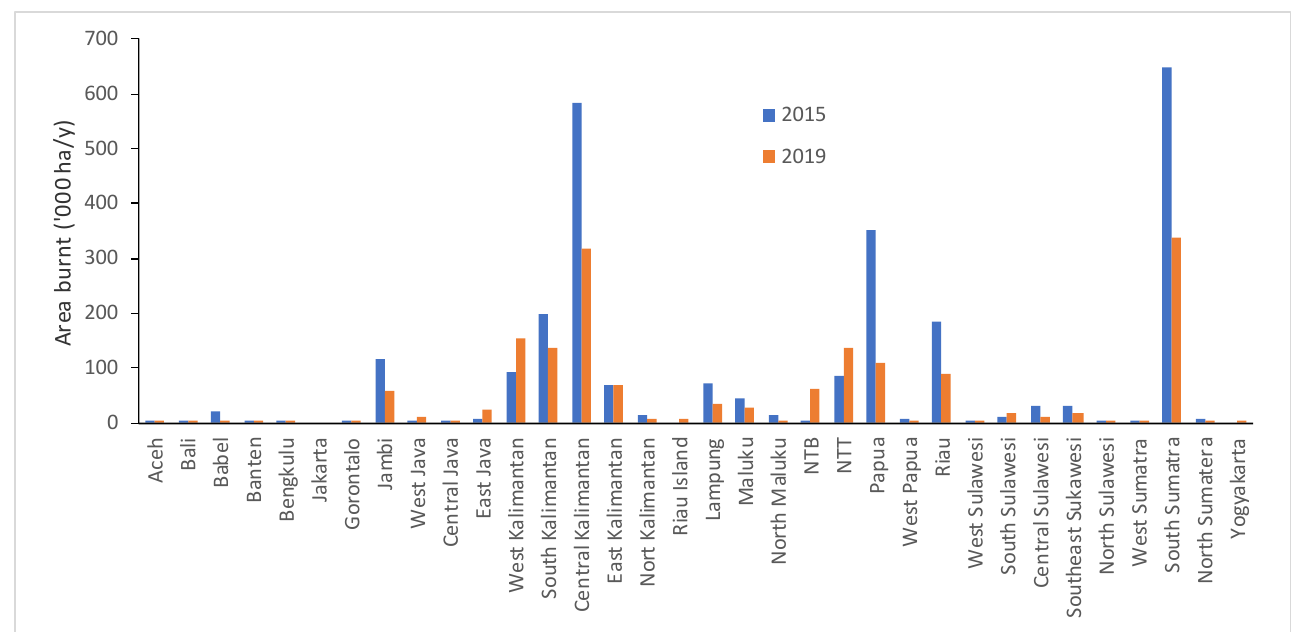
Figure 1. Area of forest fires in Indonesia in 2015 and 2019 periods (source, [8]).